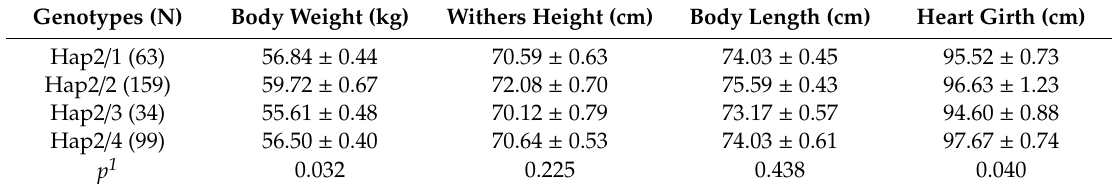
Table 5. Association of di ff erent genotypes of SNPs in SIRT1 with growth traits in Tibetan sheep. Genotypes